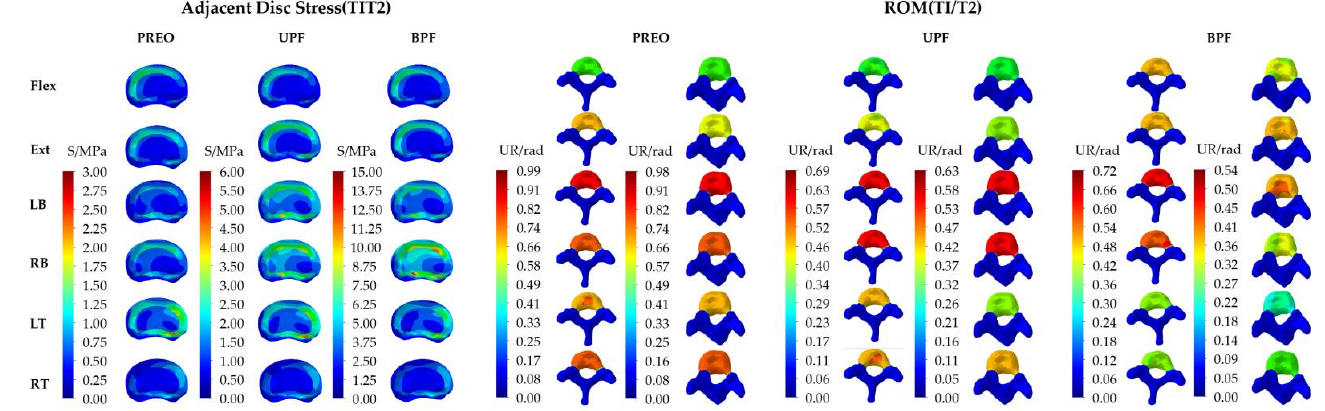
Figure 9. IVD stress distribution and T1/T2 ROM distribution in SAS. The ROM of IVD (T1/T2) was defined as the different values between T1 and